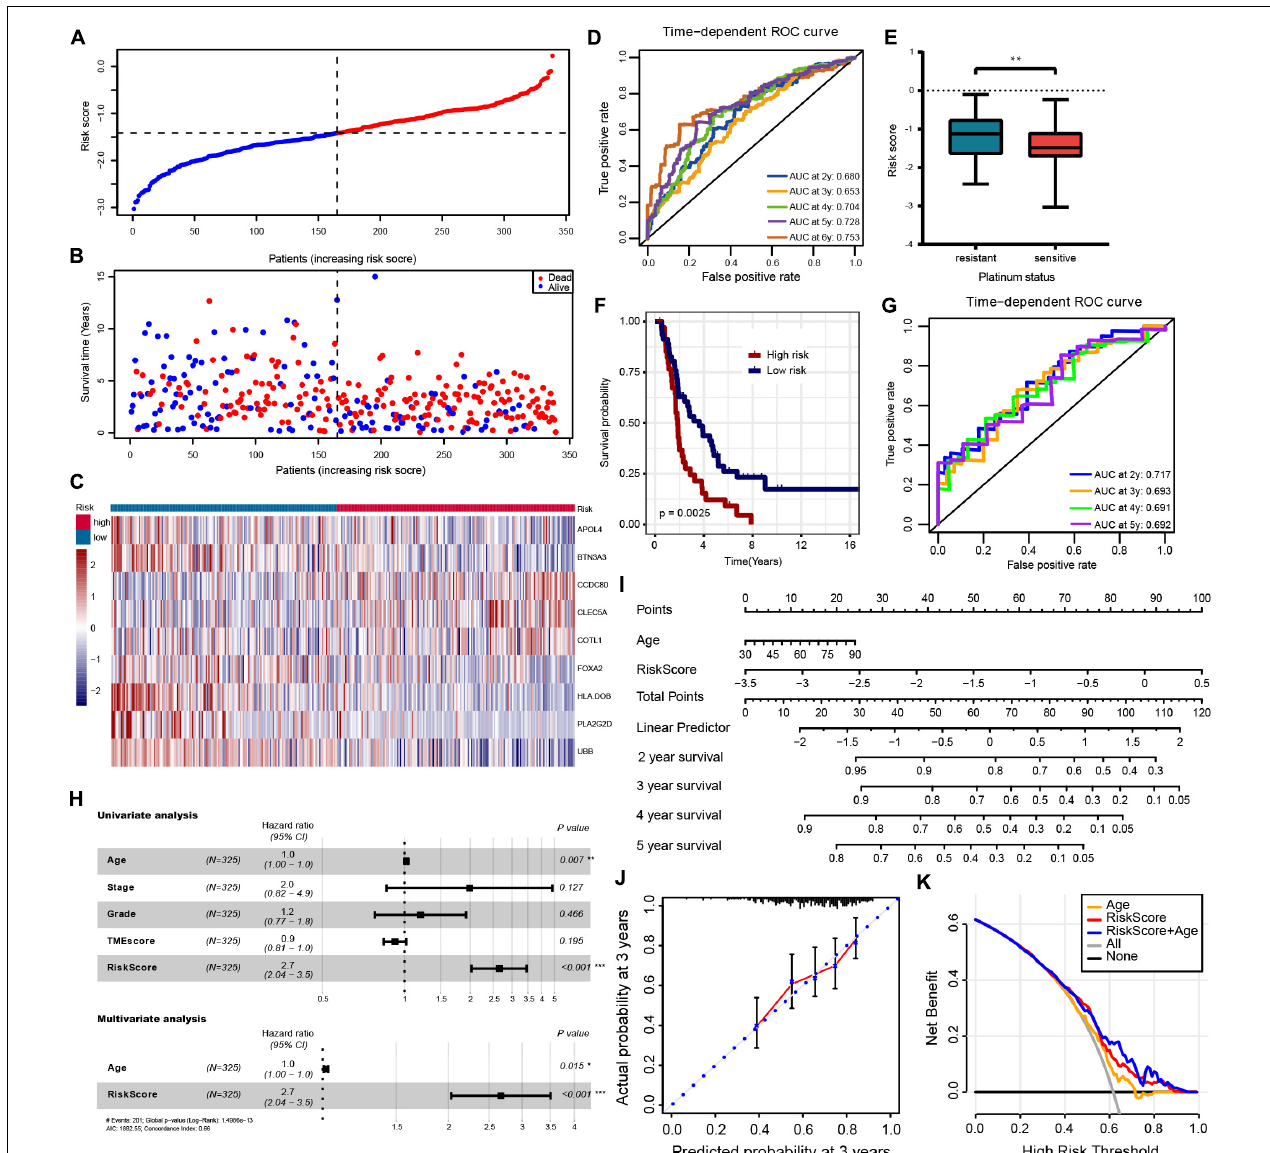
FIGURE 4 | (A–C) The risk score distribution, patients’ survival status and gene expression profiles are displayed; the black-dotted line divided patients into high- and low-risk groups. (D) Time-dependent receiver operating characteristic (ROC) curve analysis of survival prediction by the prognostic model. (E) The risk score of platinum-resistant patients with OC is significantly higher than that of platinum-sensitive patients. (F,G) OS K–M curves and time-dependent ROC curves for the prognostic model in the ICGC OV-AU cohort. (H) Univariate and multivariate associations of the prognostic model and clinical characteristics with OS. (I) The nomogram is applied by adding up the points identified on the point scale for each variable. The total points projected on the bottom scales indicate the probability of 2-, 3- 4-, and 5-year OS. (J) The calibration curve for predicting 3-year OS for patients with OC; the Y -axis represents actual survival, as measured by K–M analysis, and the X -axis represents the prognostic model-predicted survival. (K) The net benefit ( Y -axis) of age, risk model, and the nomogram; the black solid line represents the assumption that all patients survived, the gray solid line represents the assumption that no patients survived, and the orange, red, or blue solid lines represent the age, risk model, and nomograms. *** p < 0.001; ** p < 0.01; * p <